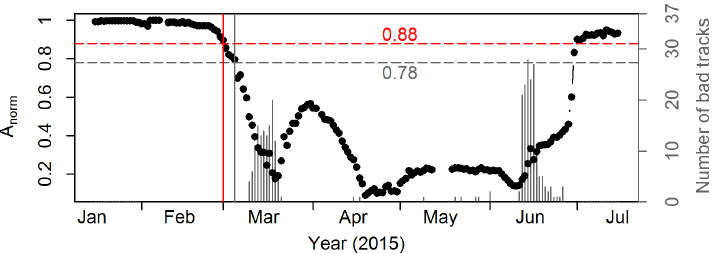
Figure 2. Normalized amplitude ( A norm ) time series (black dots) and probability distribution (grey bars) of low quality tracks among all available satellite tracks on a daily basis from 16 January to 15 July 2015. The empirical A norm threshold (0.78) is shown by the grey dashed line, and the soil moisture can be retrieved from 16 January to 5 March 2015 depending on it. Our field intuitive estimated A norm threshold (0.88) depending on the A norm in post-harvest (after 30 June) is shown by the red dashed line, and it indicates the soil moisture can be retrieved from 16 January to 1 March